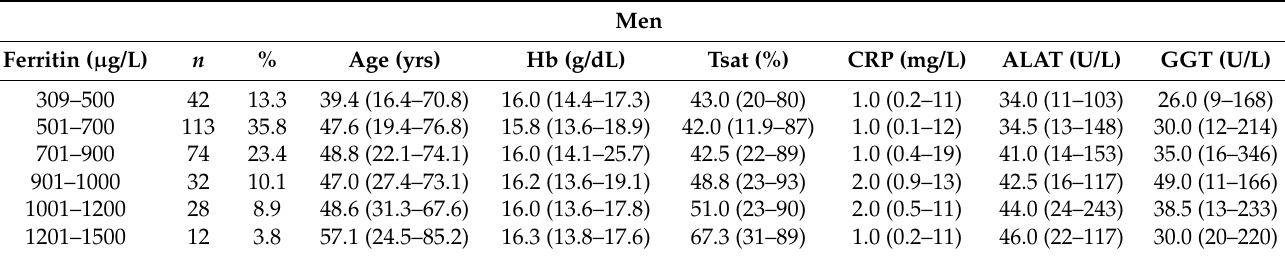
Table 3. Median (range) age and biochemical indices at increasing ferritin